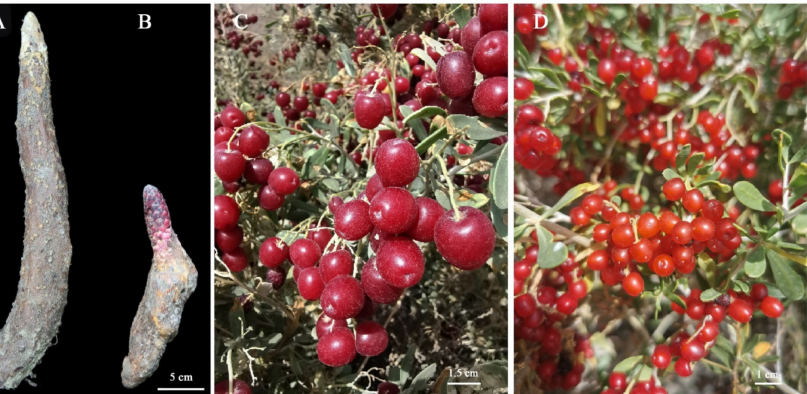
Figure 11. Morphological characteristics of stems of C. songaricum at vegetative growth stage and aerial parts of N. roborowskii and N. sibirica . Images ( A , B ) represent stems host in the roots of N. roborowskii and N. sibirica , and Images ( C , D ) represent aerial parts of N. roborowskii and N. sibirica ,